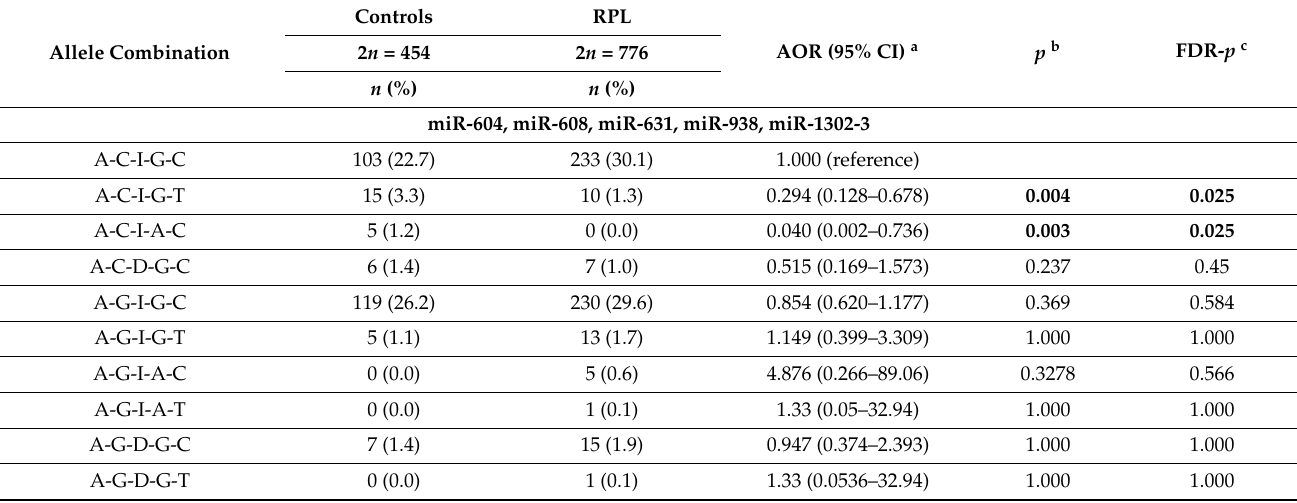
Table 3. MDR-based allele-combination analysis of microRNA polymorphisms in idiopathic RPL patients and